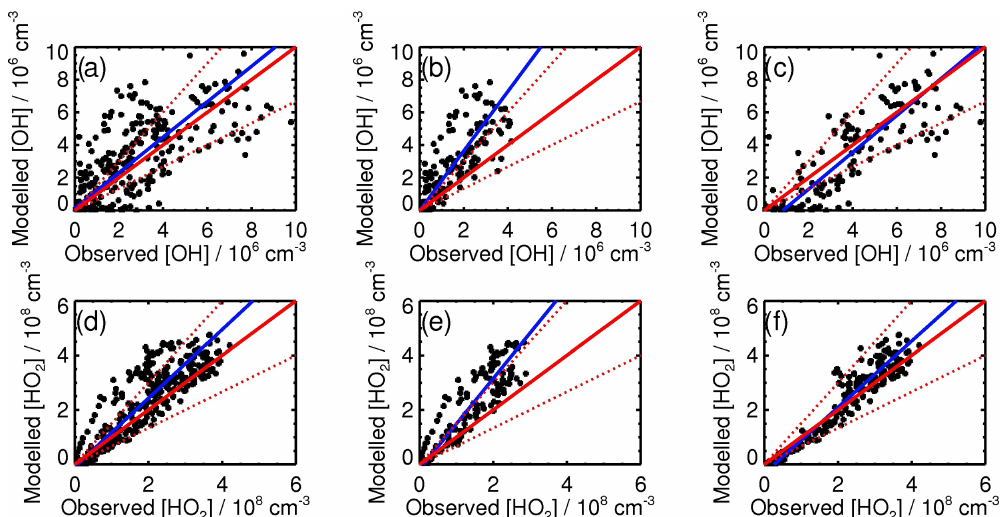
Figure 2. Comparison of modelled and observed concentrations of (a) OH during SOS1 (February–March 2009) and SOS2 (May–June 2009); (b) OH during SOS1; (c) OH during SOS2; (d) HO 2 during SOS1 and SOS2; (e) HO 2 during SOS1; (f) HO 2 during SOS2. In each plot, the solid red line indicates the 1 : 1 line, with 50% limits given by the broken red lines. The best fit lines are shown in blue and are described by (a) [ OH ] mod = (1.09 ± 0.11) ×[ OH ] obs + (0.13 ± 0.38) × 10 6 ( r 2 = 0.49); (b) [ OH ] mod = (1.82 ± 0.26) ×